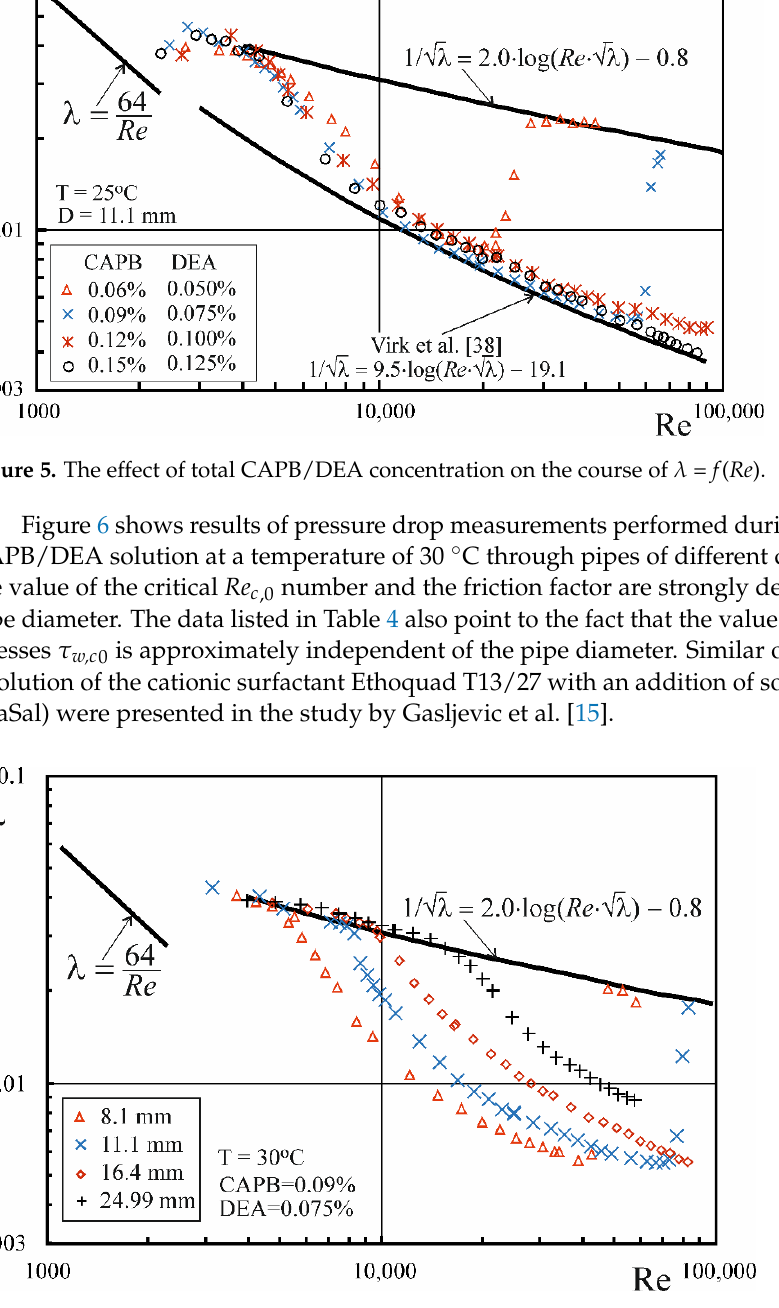
Figure 6. Friction factor for four pipe diameters (8.1, 11.1, 16.4 and 24.99 mm) as a function of ap ‐ parent Reynolds number for a CAPB/DEA